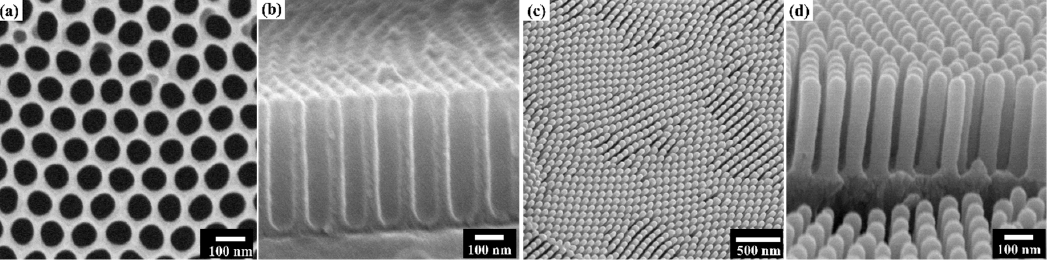
Figure 2. SEM images of ( a ) top view and ( b ) cross-section view of the AAO template, ( c ) top view and ( d ) cross-section view of well-aligned TiN NTs.